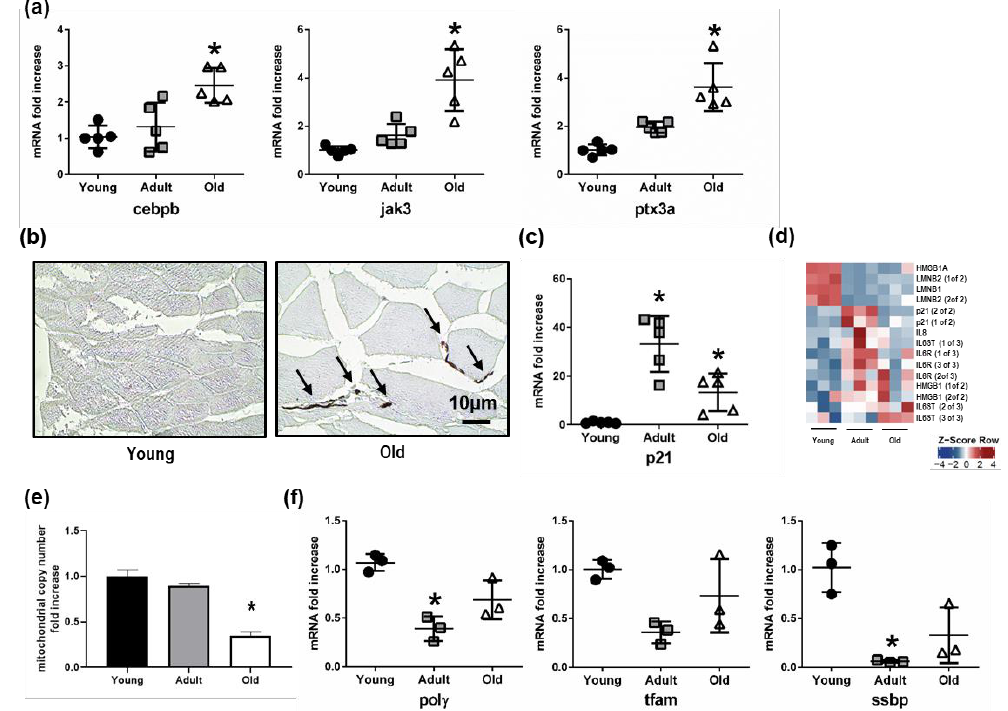
Figure 6. Senescence increases as mitochondrial number declines in the aging Nfu skeletal muscle. ( a ) Validation of sequencing results via RT-PCR analysis of mRNAs related to inflammatory signaling: CCAAT/enhancer binding protein beta (cebpb), janus kinase 3 (jak3), pentraxin 3a (ptx3a), in young (black circles), adult (gray squares), and old (white triangles) ( n = 5). * p < 0.05 vs young. ( b ) Representative light microscopic pictures from young (right) and old (left) Nfu muscle stained with Sudan Black B. Accumulation of staining in the old muscle is indicated with black arrows. Calibration bar = 10 µm. 40× magnification. ( c ) RT-PCR analysis of p21 mRNAs in young (black circles), adult (gray squares), and old (white triangles) Nfu skeletal muscle tissue ( n = 5). * p < 0.05 vs young. ( d ) Heatmap showing significantly differentially regulated senescent markers in young, adult, and old Nfu skeletal muscle identified by total RNA sequencing ( n = 3 each group). Red and blue represent over- and under-expressed genes, respectively. ( e ) RT-PCR analysis of mitochondrial content number in young, adult, and old in Nfu muscle tissue expressed as fold increase versus young samples ( n = 4). * p < 0.05 vs young. ( f ) RT-PCR analysis of mit ochondrial polymerase gamma (polγ), mitochondrial transcription factor (tfam) and mitochondrial single-stranded DNA binding protein (ssbp) in young, adult, and old Nfu muscle tissue expressed as fold increase versus young samples ( n = 3 at each age). * p < 0.05 vs young.